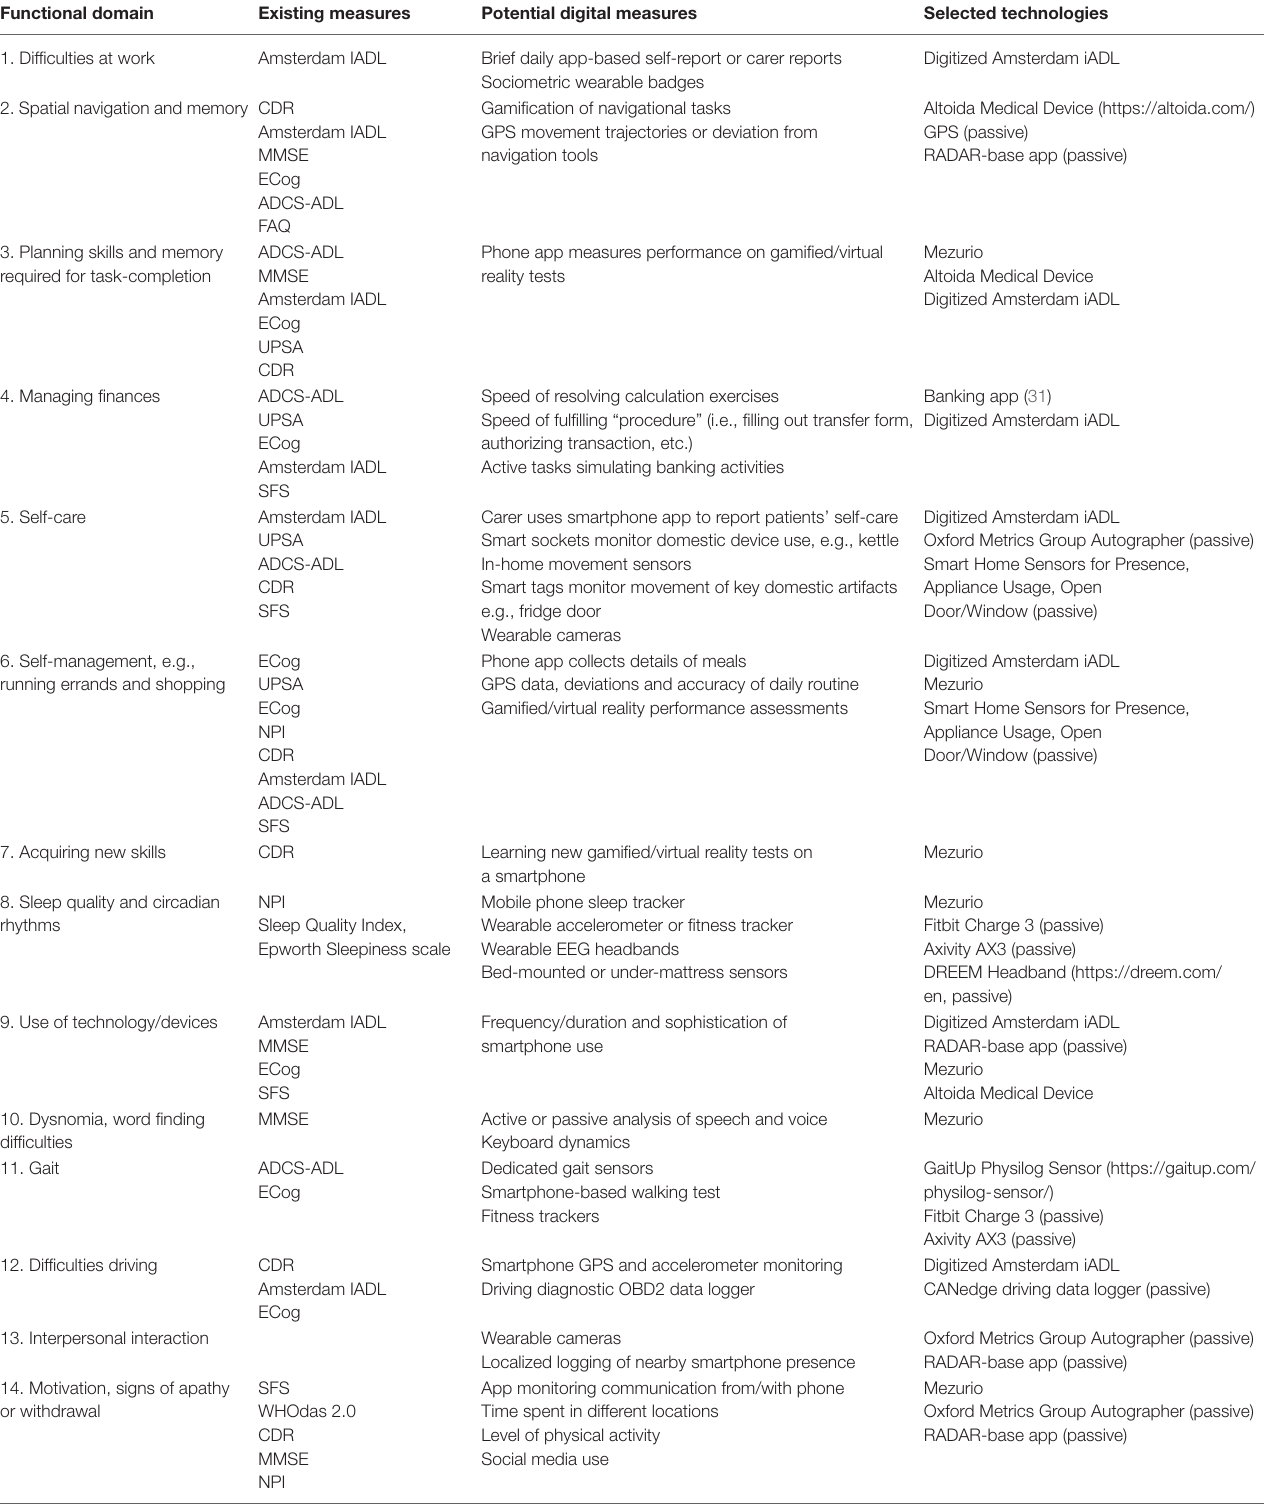
TABLE 2 | The device selection process identified remote measurement technologies that could capture digital signals from functional domains comparable to established measures of function. Functional